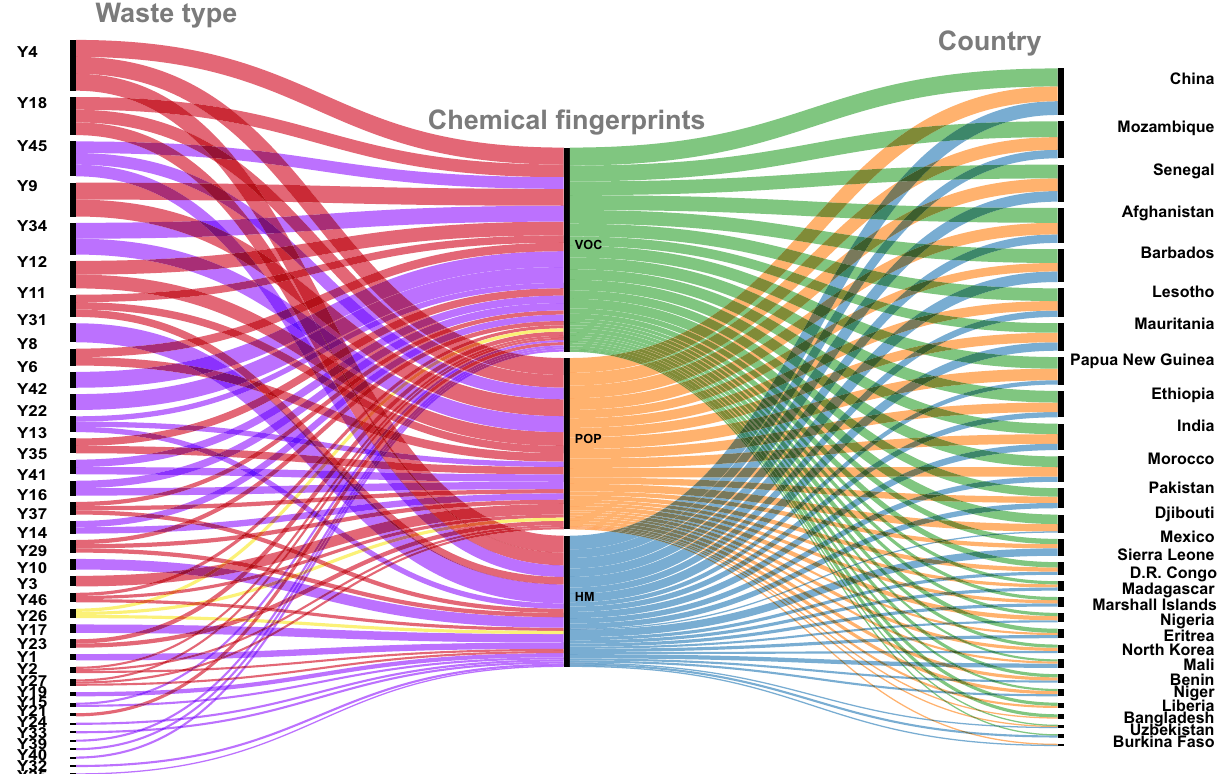
Fig. 3 Chemical fi ngerprints of waste. The three classes of chemical fi ngerprints: Volatile Organic Compounds (VOC) (green), Persistent Organic Pollutants (POP) (orange), and HM (blue) left by the three BaC waste types Y1-Y18 (red), Y19-Y45 (purple), Y46-Y47 (yellow) in the top 28 countries at high risk of improper handling and disposal of wastes (HRIHDW).